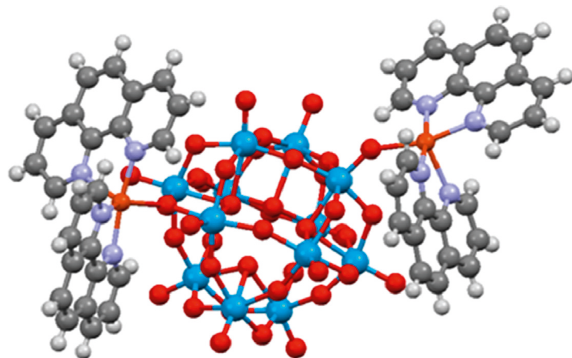
Figure 1: Ball-stick representation of the decorated Keggin anion in 1 .